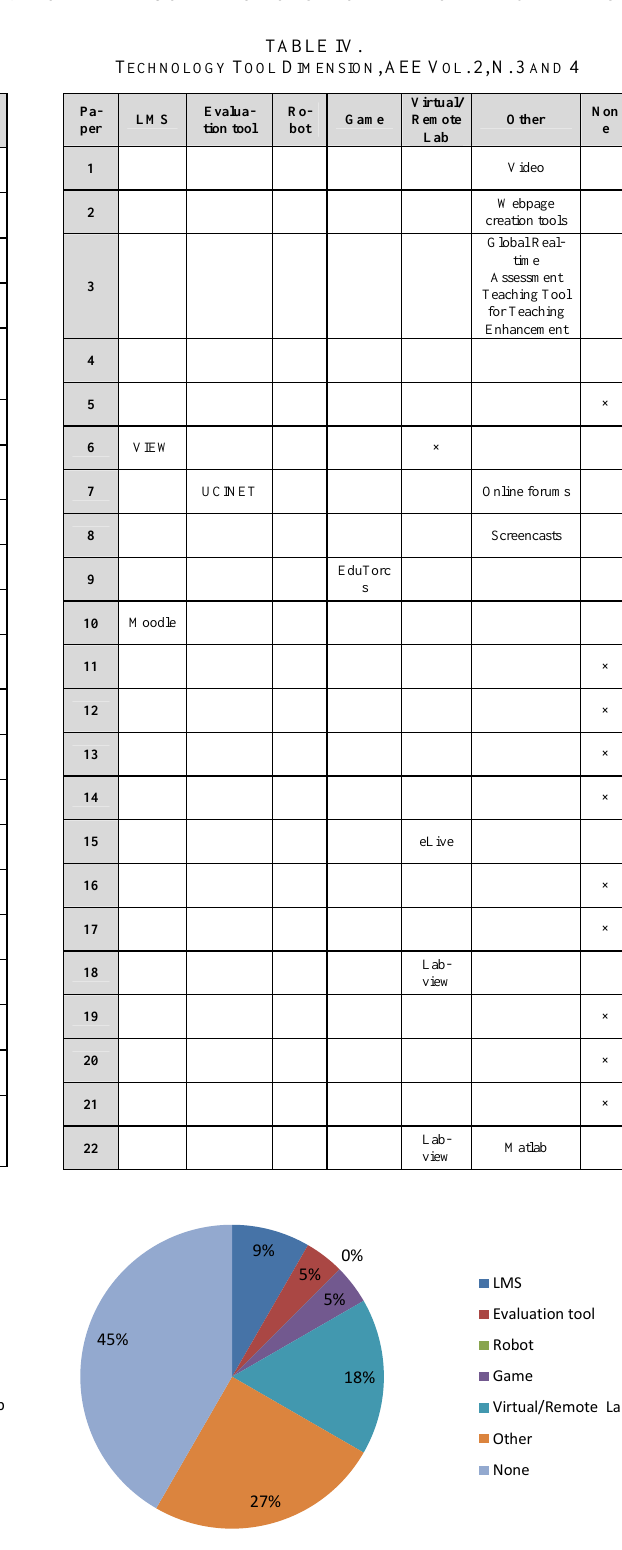
Figure 4. Technology Tool Dimensions, AEE Vol.2, N: 3 and